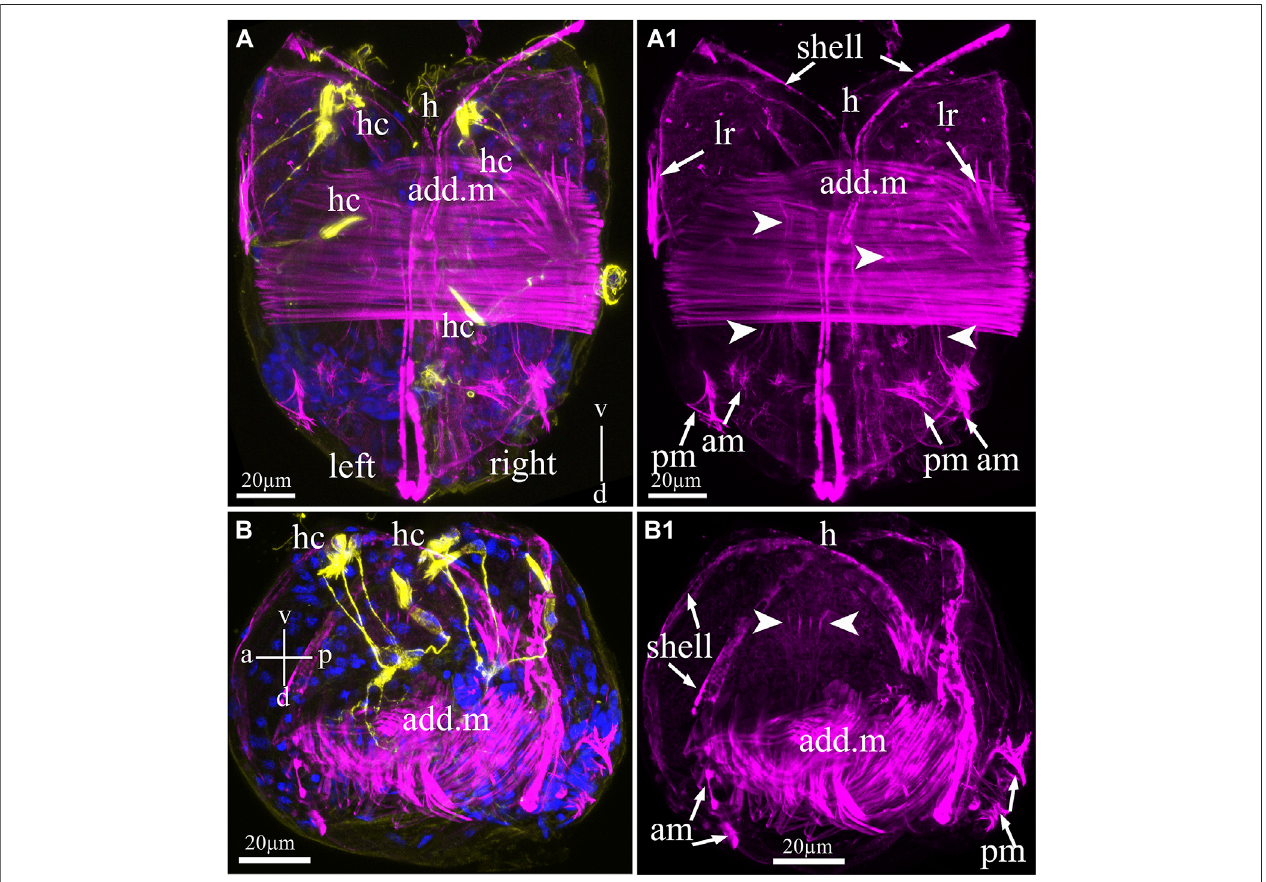
FIGURE 5 | Myoanatomy of Nodularia douglasiae glochidia. (A,A1) Posterior view. (B,B1) Lateral view. The specimen was observed using confocal images produced by phalloidin staining (magenta) to visualize the larval muscle systems (A – B1) and anti-acetylated tubulin (yellow) antibody (A,B) together with DAPI (A,B) . (A,A1,B,B1) Confocalmicrographofthelarvalmusculature. Arrowheadspointtosmoothmassivemuscle(adductor,add.m)inthecentralpartofthelarva,whilearrows indicate that larval retractors (lr) are located on the edges of the shell (left and right) and anterior and posterior muscle bundles (AM and PM) (A1,B1) . (B1) On the lateral side of the larva, it is possible to distinguish separate muscle fi bers indicated by arrowheads. (A) Vertical v-d labelled line refers to ventro-dorsal body axes. (B) Vertical v-d labelled line refers to ventro-dorsal body axes and horizontal line a-p labelled line refers to anterior-posterior body axes of larva. Abbreviations: add. m, adductor muscle; am, anterior muscle; h, hook; hc, hair cells; lr, larval retractors; pm, posterior muscle. Scale bars, (A – B1) , 20 μ m.